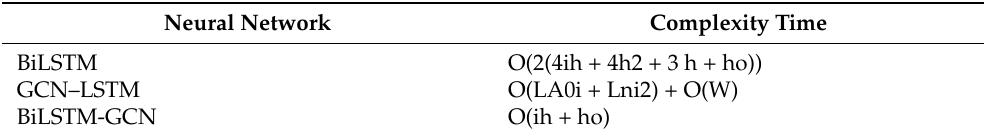
Table 3. Time complexity of DNN